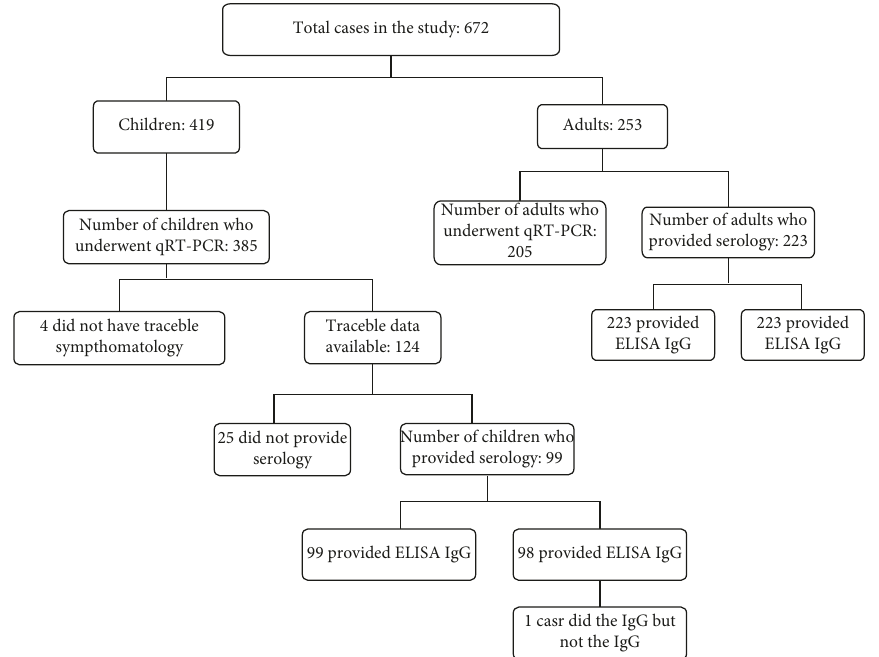
Figure 2: Number of test results included in the study.